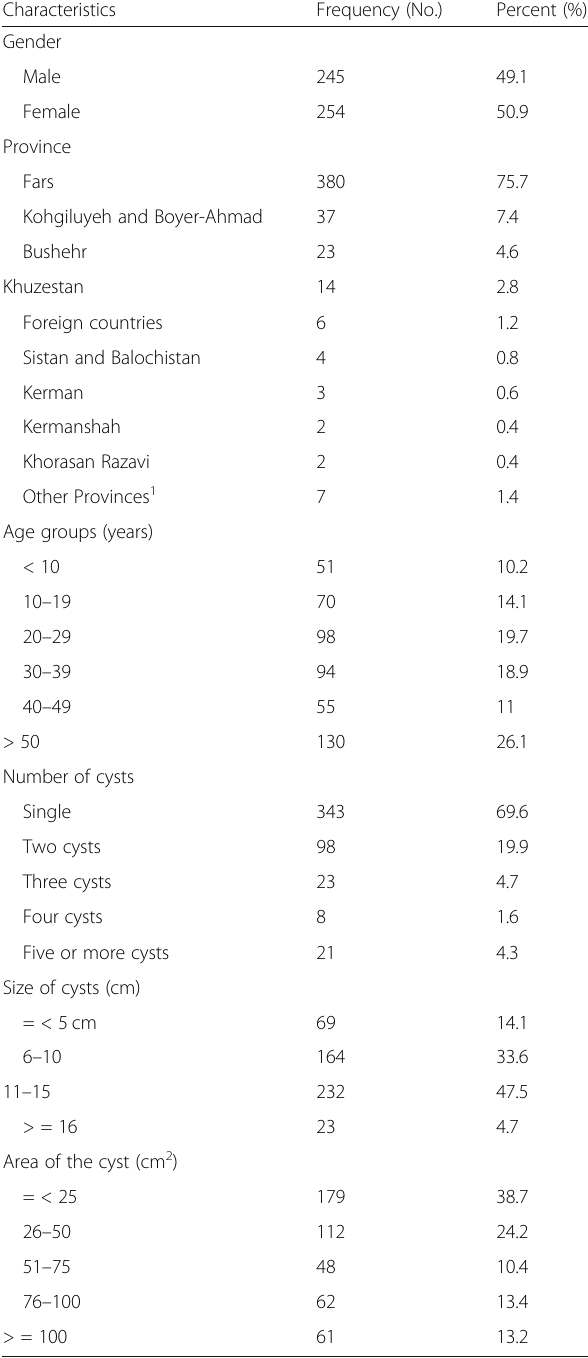
Table 2 Demographic features of the CE patients along with the cyst